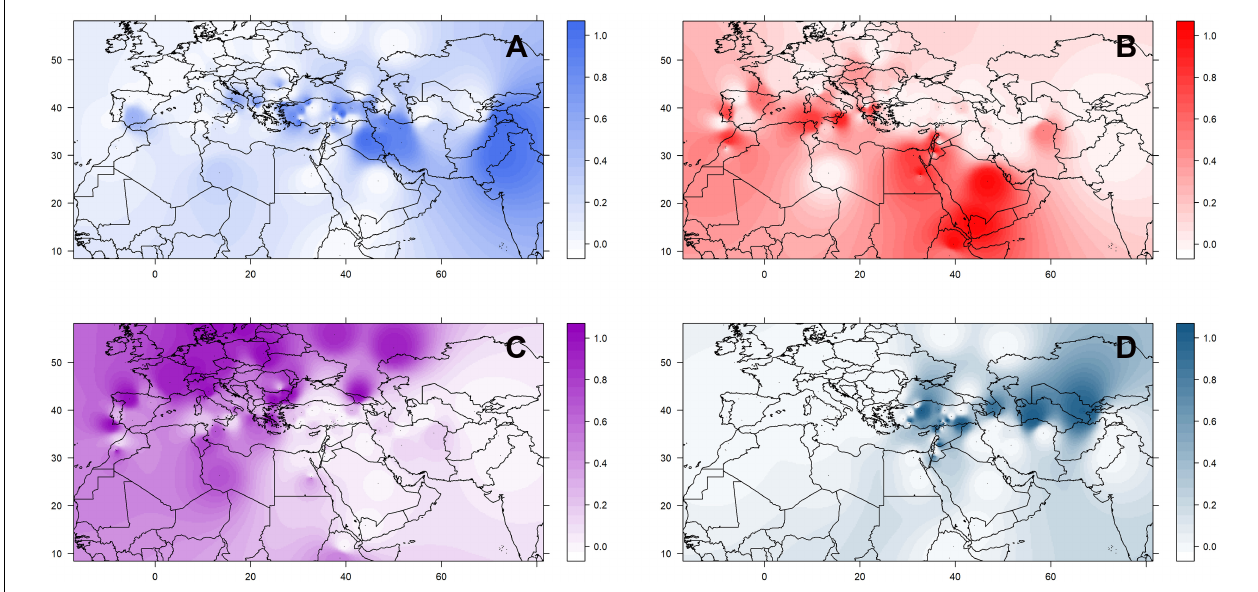
FIGURE 3 | Geographical distribution of the four groups (A–D) of L. culinaris identified in the STRUCTURE model K = 4. Spatial interpolation is based on the Q -matrix of proportional memberships of individual accessions to each of the four groups.